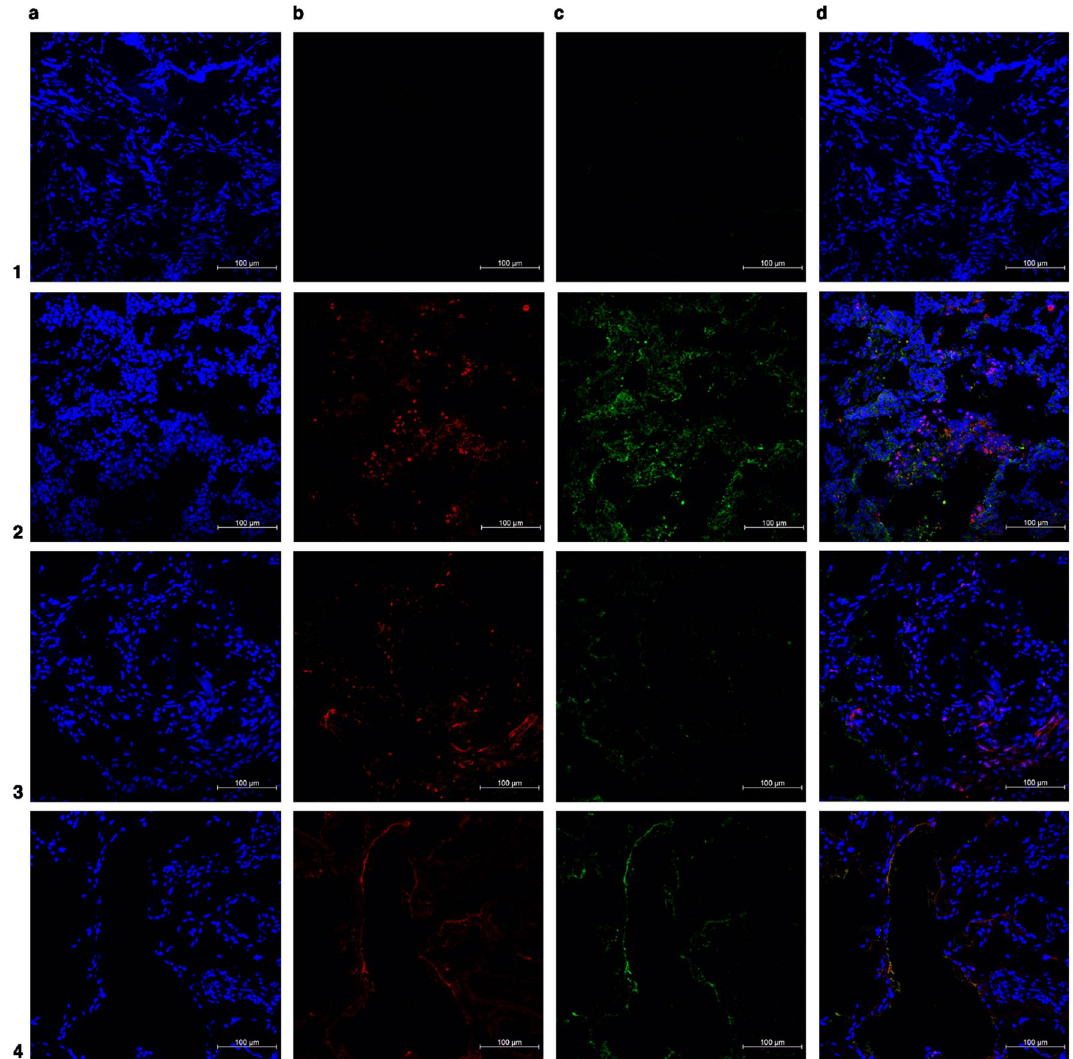
Figure 3. Representative immunofluorescence costained images of superficial peritoneal endometriosis. ( a ) In blue: DAPI ( b ) in red: senescent associated biomarkers (p16 or lamin b1) ( c ) in green: anti-E-cadherin antibody (epithelial glandular cells) ( d ) merged. Number 1 row represents negative control (endometriotic superficial lesions), number 2 row represents positive control (endometrial cancer or random ovary), number 3 row represents superficial endometriosis labeled with p16, and number 4 row represents superficial endometriosis labeled with lamin b1. ×20